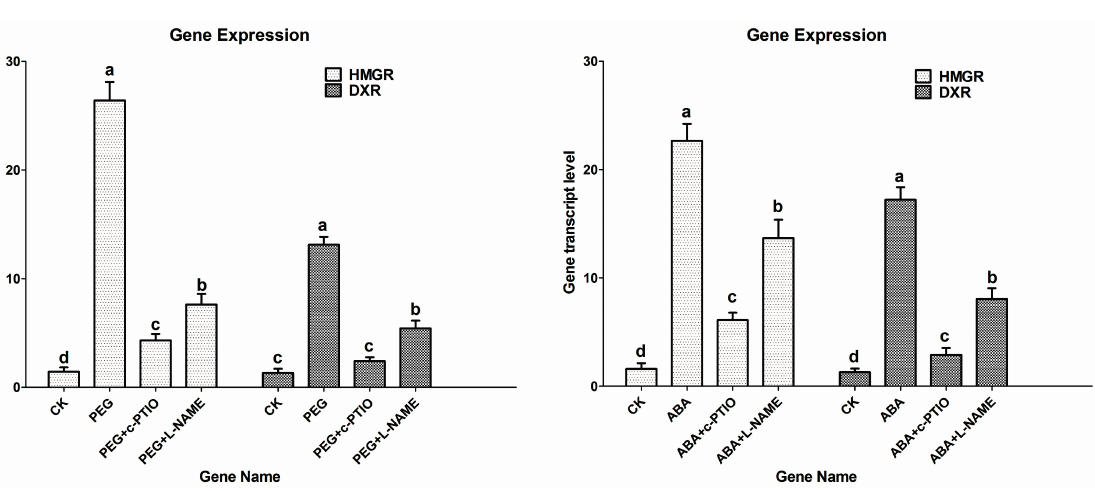
Figure 3. Generation of NO in S. miltiorrhiza hairy roots induced by 2% PEG and 200 µM ABA. CK, the control; PEG, polyethylene glycol; ABA, abscisic acid; L -NAME: N ω -nitro- L -arginine methyl ester, 200 µM; c-PTIO, 2-(4-Carboxyphenyl)-4,4,5,5- tetramethylimidazoline-1-oxyl-3-oxide (200 µM). Different letters (a, b, c and d) indicate significant difference at p ≤ 0.05. Means ± standard deviation (S.D.) ( n = 3) are shown.